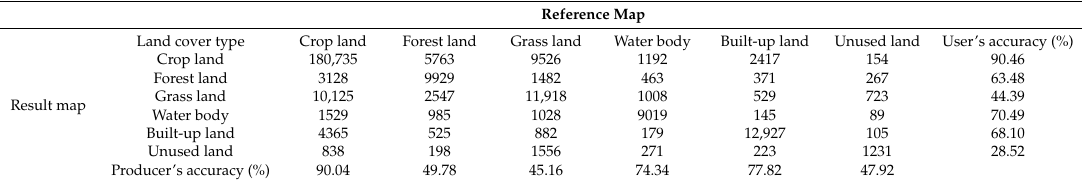
Table 4. Confusion matrix between the improved rotation forest result and the reference data before EVI preprocessing.